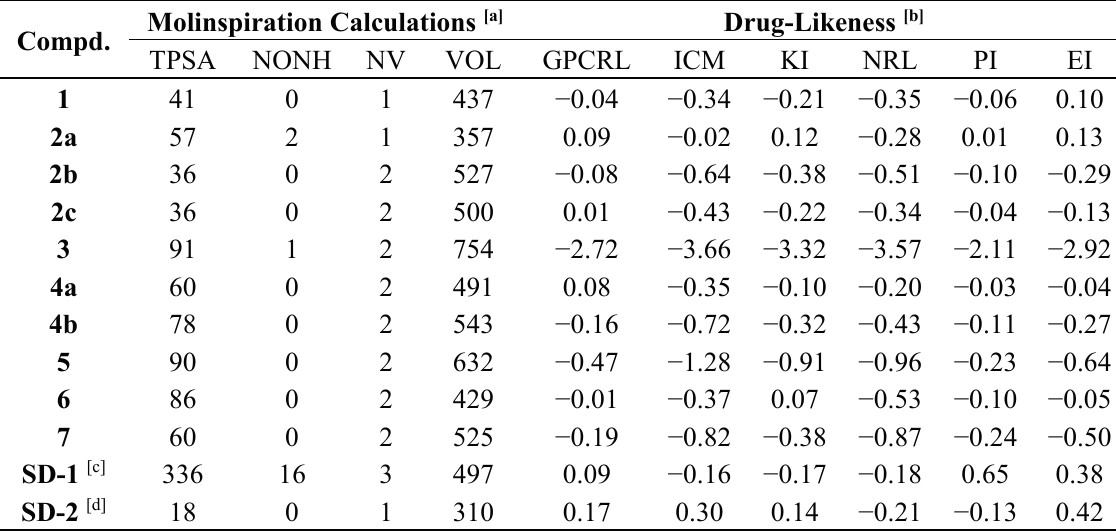
Table 3. Molinspirationcalculations of compounds ( 1 – 7